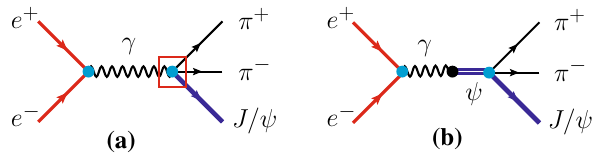
Fig. 1 Two schematic diagrams for the e + e − → π + π − J /ψ process. Here, diagrams a and b are due to nonresonance and intermediate char- monia contributions, respectively (color online)